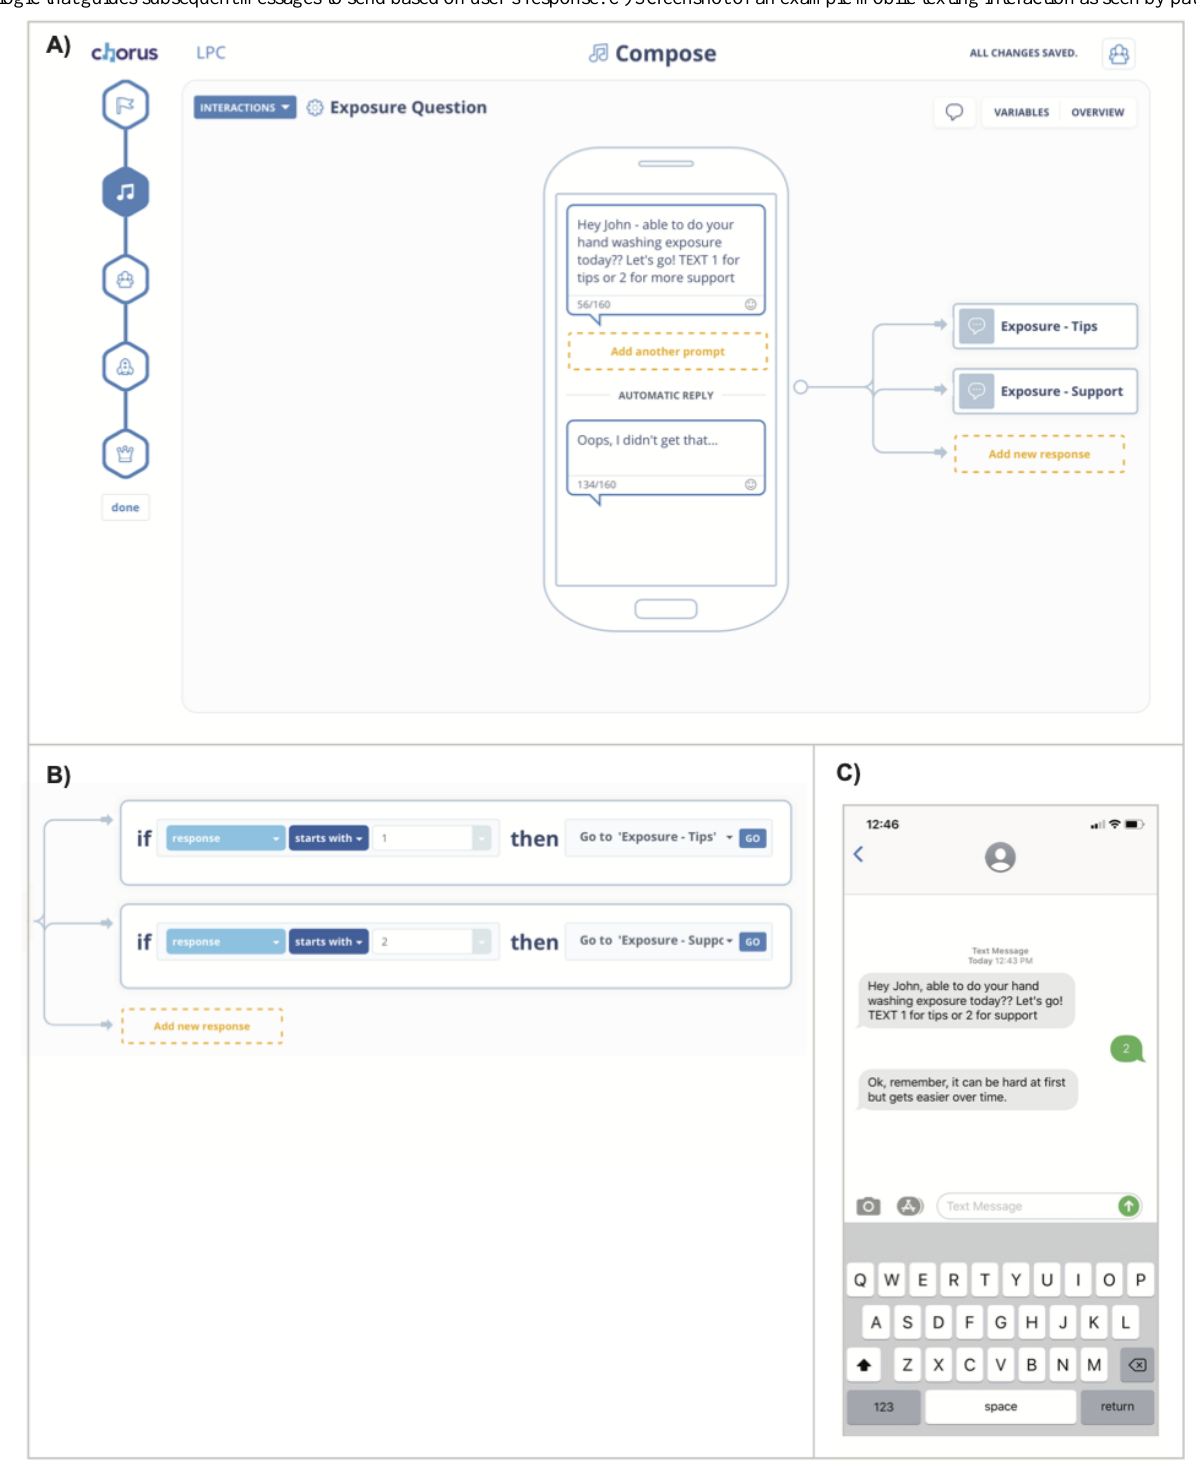
Figure 2. Visually creating apps with Chorus. A) Creation of text messaging content visually with a simulated phone. B) Visual interface to